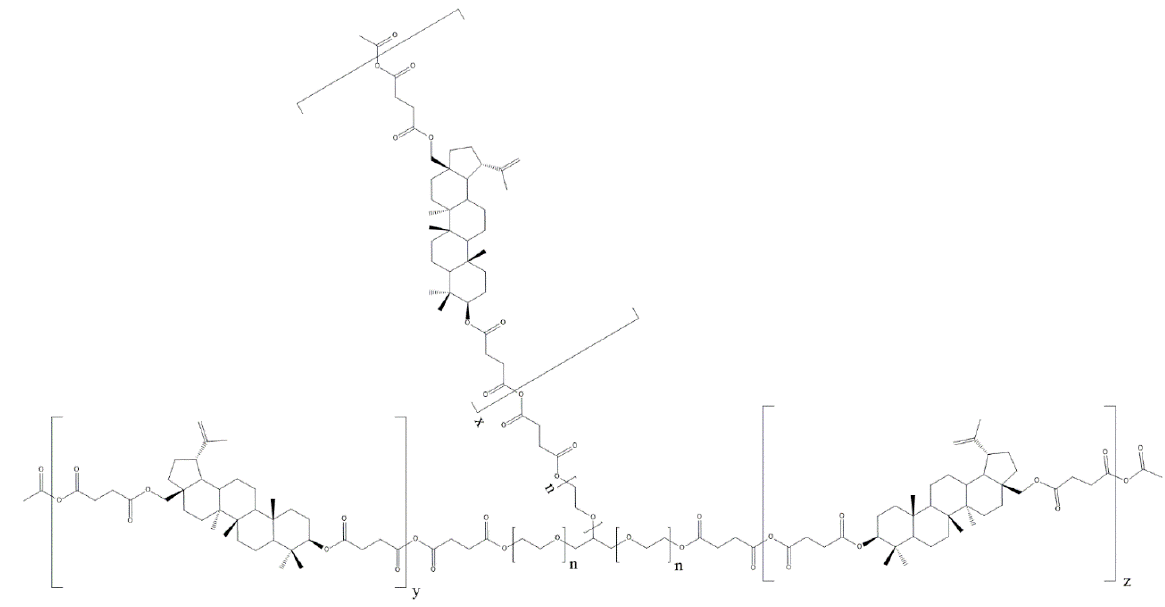
Figure 4. Structure of polyDBB_PEG_COOH.